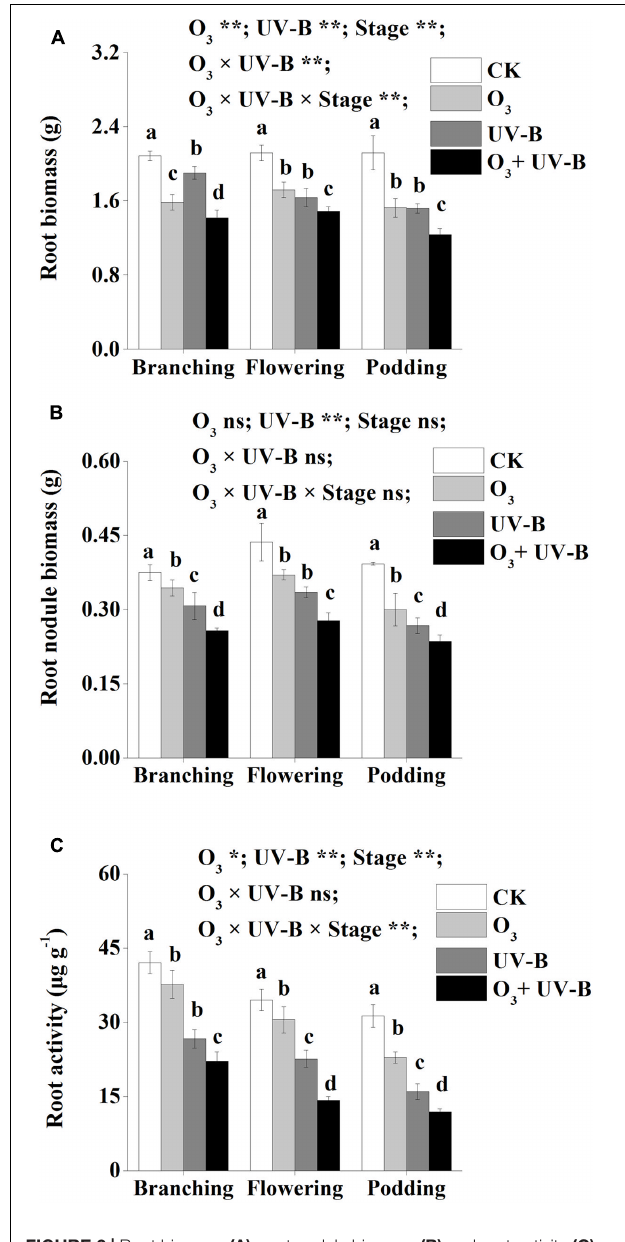
FIGURE 2 | Root biomass (A) , root nodule biomass (B) and root activity (C) of soybean in response to control treatment (CK), elevated O 3 treatment (O 3 ), enhanced UV-B radiation treatment (UV-B) and O 3 + UV-B treatment (O 3 + UV-B) at stages of branching, flowering and podding. Different letters above the bars represent significant differences from Tukey’s multiple comparisons among four treatments ( P < 0.05). For each parameter, results of three-way ANOVA are reported, with asterisks showing the significance of factors [elevated O 3 treatment (O 3 ), enhanced UV-B treatment (UV-B) and growth stage of soybean (Stage)] and their interaction for: ∗∗ P < 0.001, ∗ P < 0.05, ns: